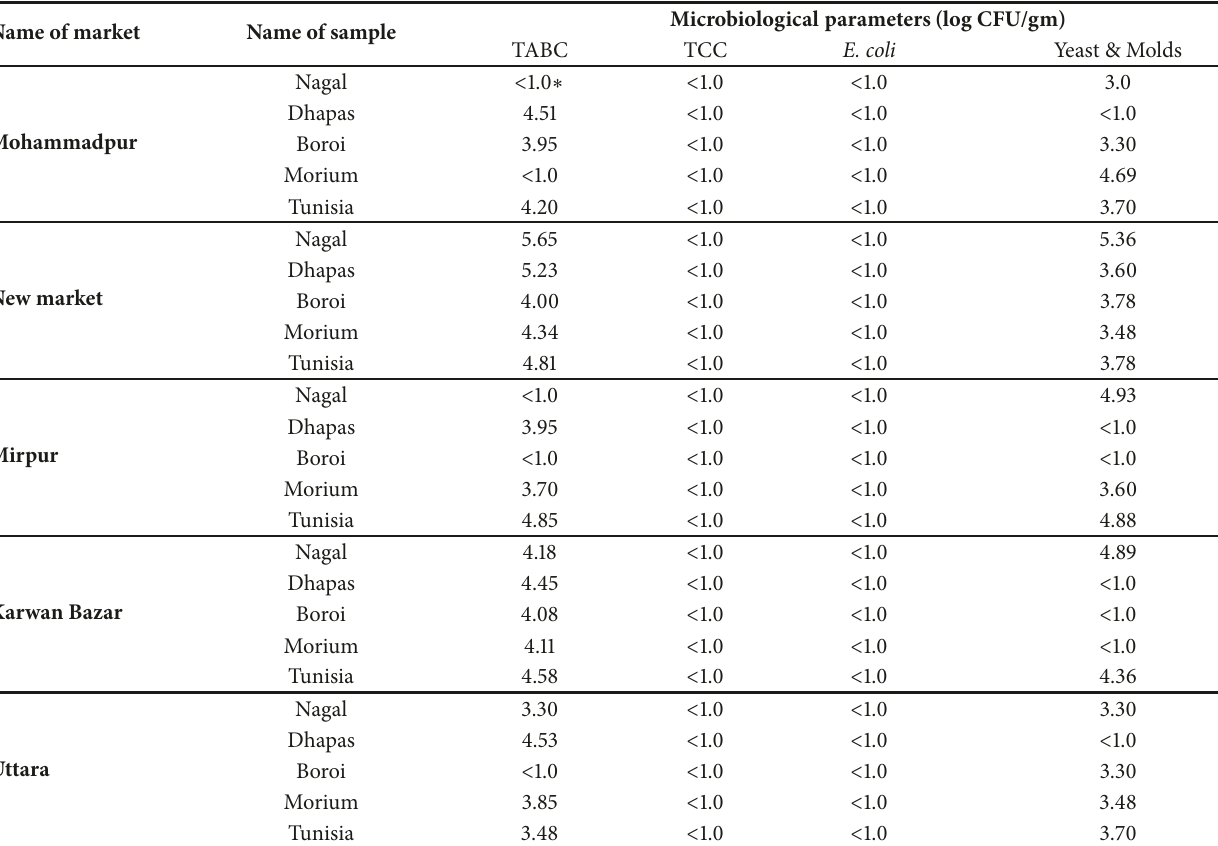
Table 2: Microbiological analysis of fresh date flesh